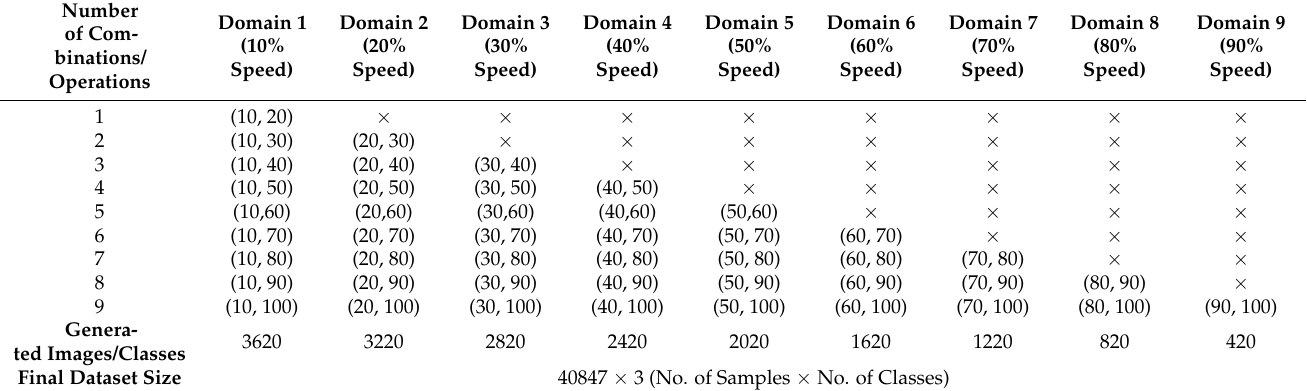
speed. Table 4. Final dataset with possible combinations of domain knowledge